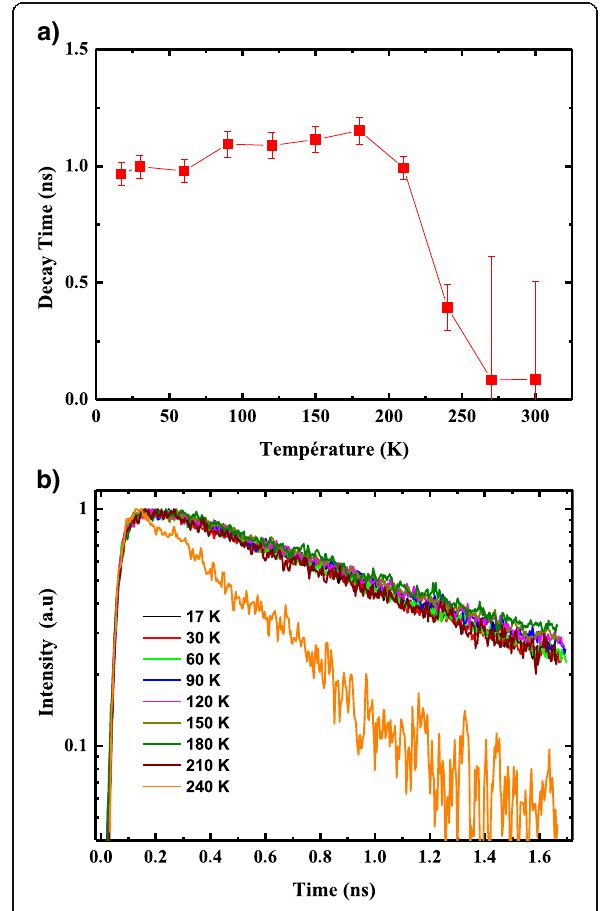
Fig. 8 a Decay time of the LQDs peak versus the sample temperature for a wavelength excitation of 514 nm. b Typical photoluminescence decay intensity versus the temperature of the LQD peak measured at an excitation wavelength of 514